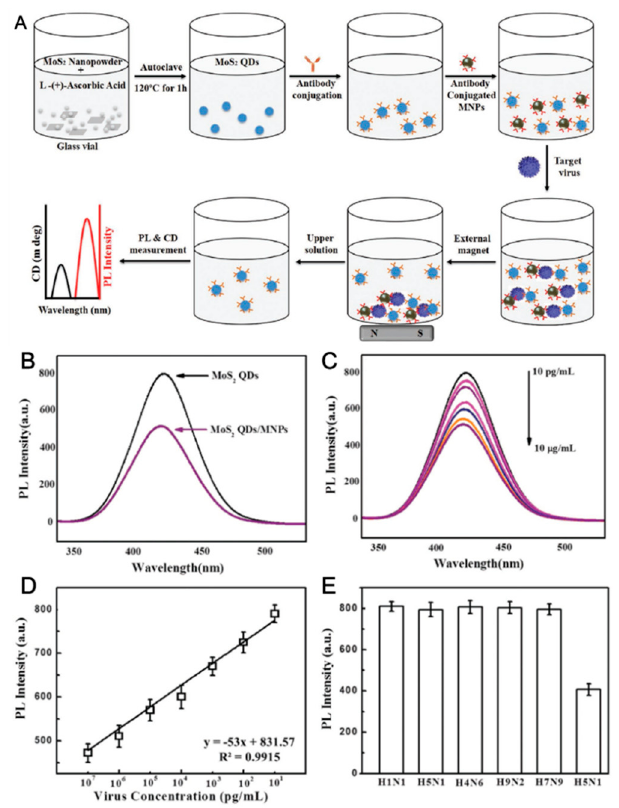
Figure 5. ( A ) Schematic presentation of the overall experimental design: MoS 2 nanopowder and ascorbic acid are mixed in a glass vial; Upon autoclaving, MoS 2 QDs were formed; aptamer-quantum dots (QDs) were conjugated with antibodies through a layer-by-layer (LBL) method; antibody-conjugated magnetic nanoparticles (MNPs) were added to it; target virus was added and nanostructured magnetochirofluorescent was formed, which were separated by an external magnet; upper solution was collected and tested for optical responses. Fluorescence detection of avian influenza virus A (H5N1): ( B ) PL response before and after nanohybrids formation; ( C ) PL spectra of QDs with different concentrated target virus solution; ( D ) calibration curve of PL intensity versus virus concentration; and ( E ) selectivity results of fluorescence-based sensor. (Reproduced with permission from [79], published by WILEY-VCH Verlag GmbH & Co. KGaA, 2018). Table 2. Comparison of the localized-surface plasmon resonance (LSPR)-based biosensor and fluorescence (FL)-based for AIV detection in terms of receptor materials, nanobio hybrid material, detection method, detection limit and target.